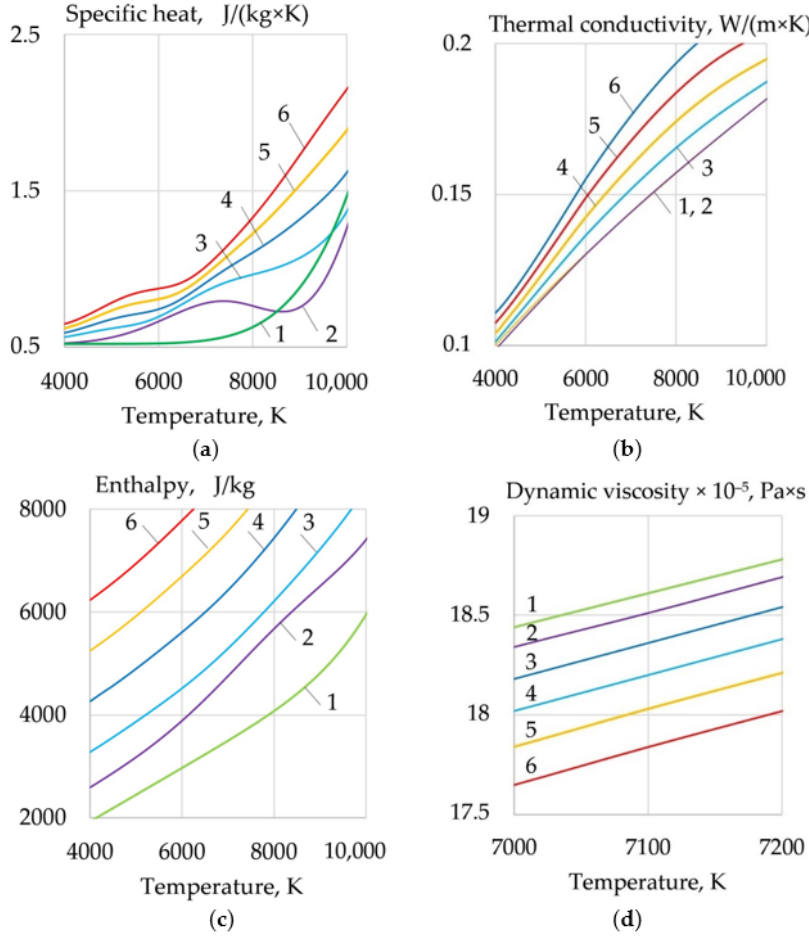
Figure 7. Change in specific heat ( a ), thermal conductivity ( b ), enthalpy ( c ), and dynamic viscosity ( d ) of an equilibrium system at 0.1 MPa, wt.%: (1) 100Ar; (2) 95Ar + 5Fe; (3) 90Ar + 5Fe + 5LaB 6 ; (4) 85Ar + 5Fe + 10LaB 6 ; (5) 80Ar + Fe + 15LaB 6 ; (6) 75Ar + 5Fe + 20LaB 6 .